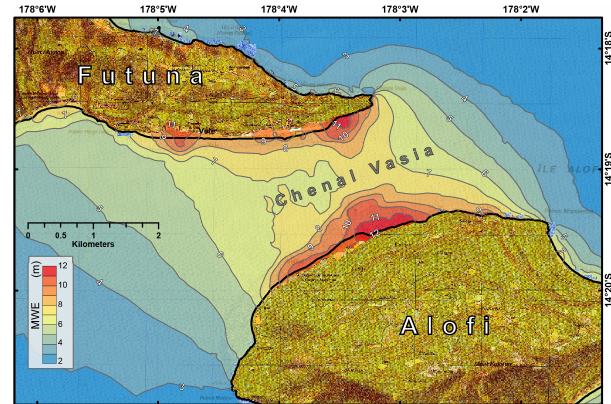
Figure 13. Maximum wave elevation (in m) and inundation map along the eastern tip of Futuna and NE Alofi from a M W = 9.1 Tonga Earthquake. The coastline is highlighted by the bold line. MWE contours in